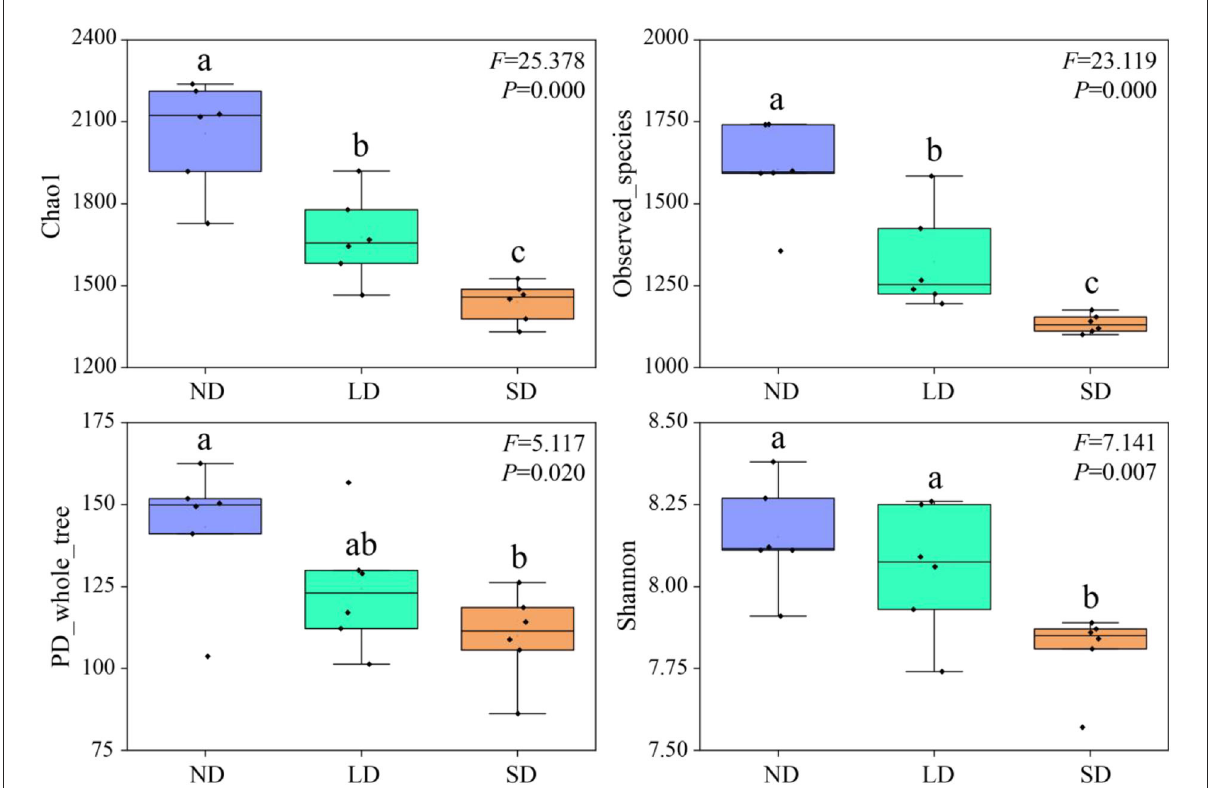
FIGURE2 Abundance and diversity index of nitrogen-fixing bacteria community. ND is non-degradation and LN and SD are the light and severe degradation stages of the alpine wetland, respectively. The center mark in each box diagram represents the median, and the bottom and top edges of the box represent 25 and 75%, respectively. Different lowercase letters represent significant differences between different degradation